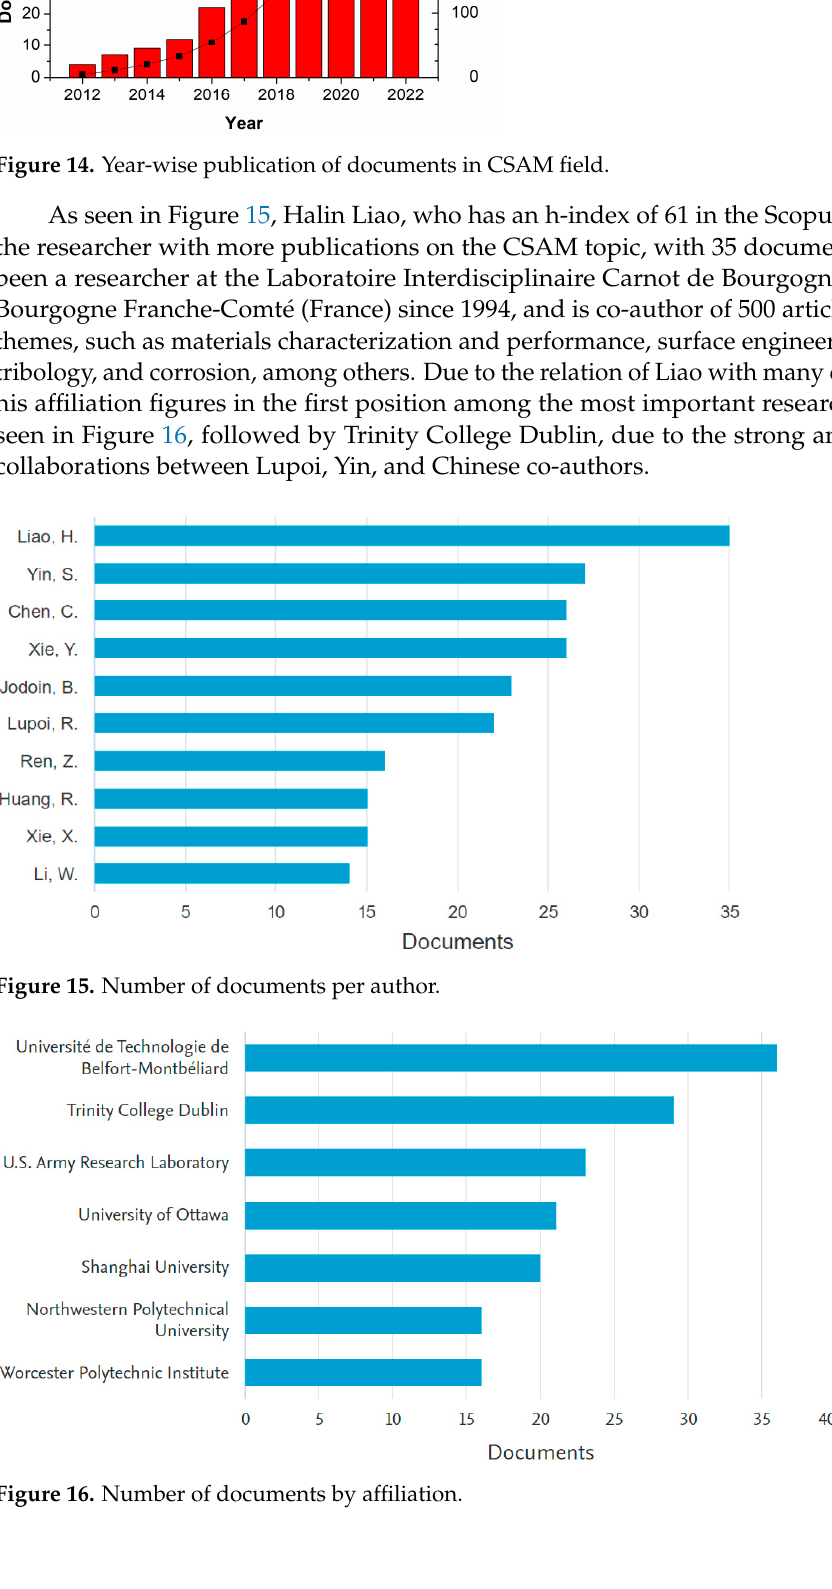
Figure 14. Year-wise publication of documents in CSAM field.